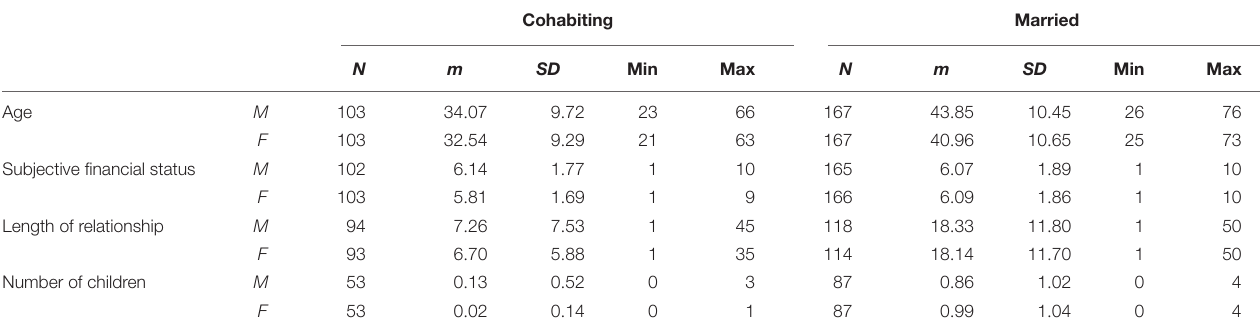
TABLE 2 | Sociodemographic characteristics of the sample.